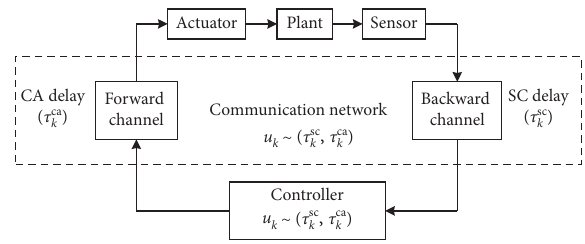
Figure 2: Typical structure of